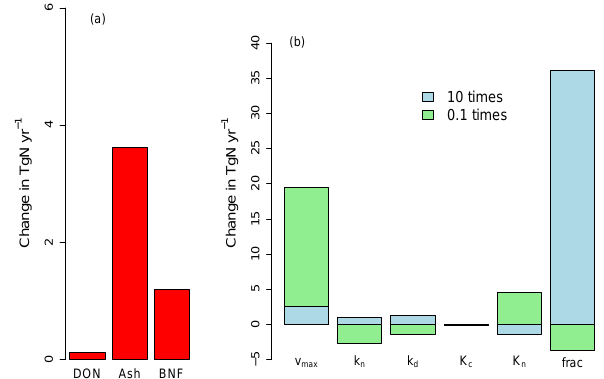
Figure 7. Changes in simulated global average N 2 O (1950–2005) emissions from modifying general N cycling processes (a) and model parameters one at a time (b) . Altered processes include dis- allowing N losses through dissolved organic matter (DON in a ) and fire volatilization (Ash in a ), and replacing simulated biological N fixation with preindustrial N fixation rate (BNF in a ). Parame- ters include: v max , the maximum active N uptake rate per unit root biomass; k n , the base nitrification rate; k d , the base denitrification rate; Kc and Kn, the half saturation constants for labile C availabil- ity and nitrate respectively; and frac is the fraction of net nitrifica- tion lost as N 2 O. Parameters are either increased by multiplying 10 (light blue) or reduced by multiplying 0.1 (light green) relative to the